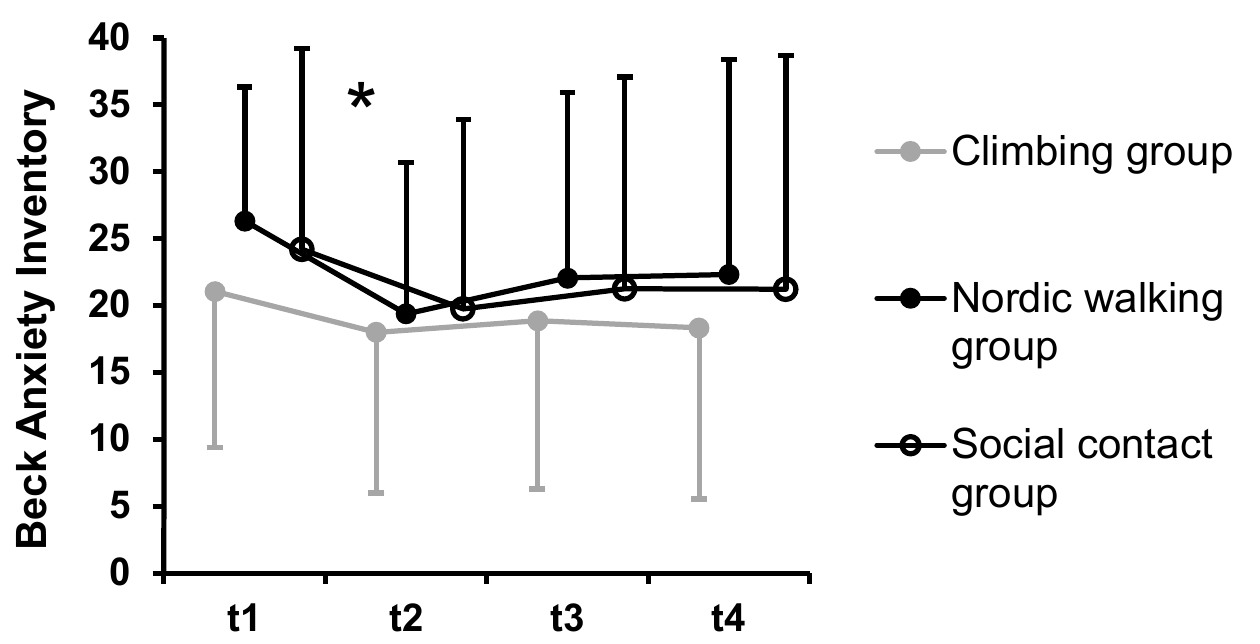
Figure 3. Symptoms of anxiety according to the Beck Anxiety Inventory-II by groups. Notes: * indicates a significant main effect of time. No significant group-by-time interaction emerged. Dots represent mean values; error bars indicate standard deviations.